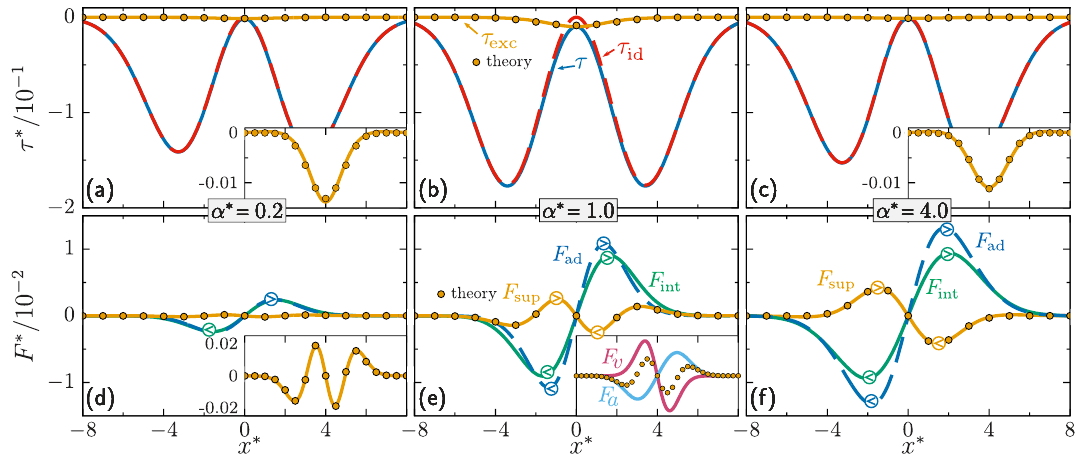
√ m ω 3 ¯ h (blue solid line) and its splitting into ideal Figure 2. Reduced kinetic stress tensor τ ∗ = τ / (red dashed line) and excess (solid yellow line) parts, Equation (6), and the theoretical prediction (yellow circles), Equation (8), for interaction lengths α ∗ = 0.2 ( a ), α ∗ = 1 ( b ) and α ∗ = 4 ( c ). Internal (green solid line), adiabatic (blue dashed line) and superadiabatic (yellow solid line) force densities, cf. Equation (7), and theoretical prediction (yellow circles), Equation (9), in reduced units, i.e., F ∗ = F / m ω 2 for interaction lengths α ∗ = 0.2 ( d ), α ∗ = 1 ( e ) and α ∗ = 4 ( f ). Data taken at t ∗ = 3. The model parameters and reduced units are identical to those in Figure 1. The insets in panels ( a , c , d ) are enlarged views of the superadiabatic terms. The inset in panel ( e ) shows the splitting of the superadiabatic force density (circles) into F v (pink) and F a